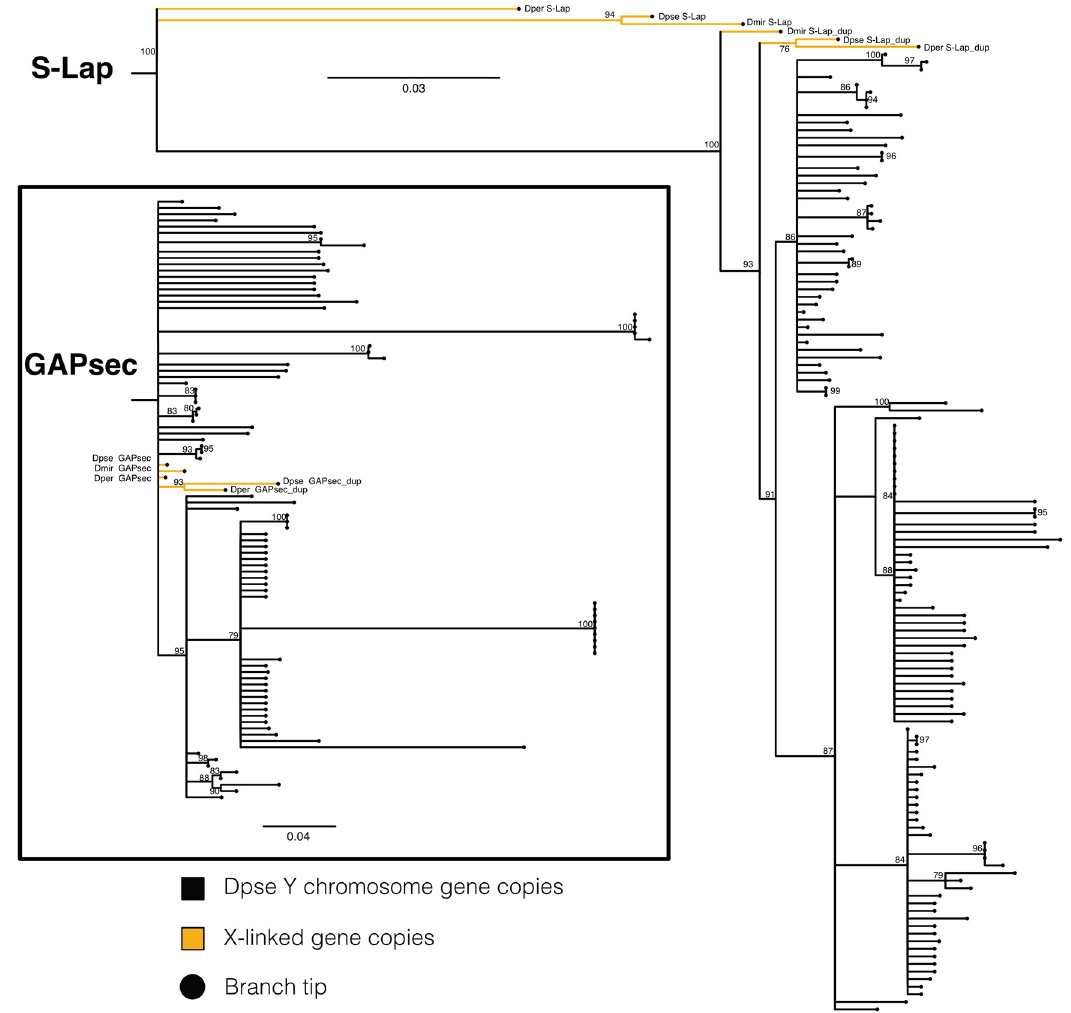
Fig 3. Phylogeny of S-Lap1 and GAPsec gene families in D . pseudoobscura . Approximately 100 copies of both S-Lap1 and GAPsec are present on D . pseudoobscura Y-linked genomic scaffolds. A RAxML maximum likelihood phylogeny was inferred from alignments of these copies and nodes with bootstrap support values of 75 or less were collapsed. X-linked copies are shown by orange branches, and Y-linked copies are shown in black. Alignments used to generate the trees shown in Fig 2 are provided as S3 and S4